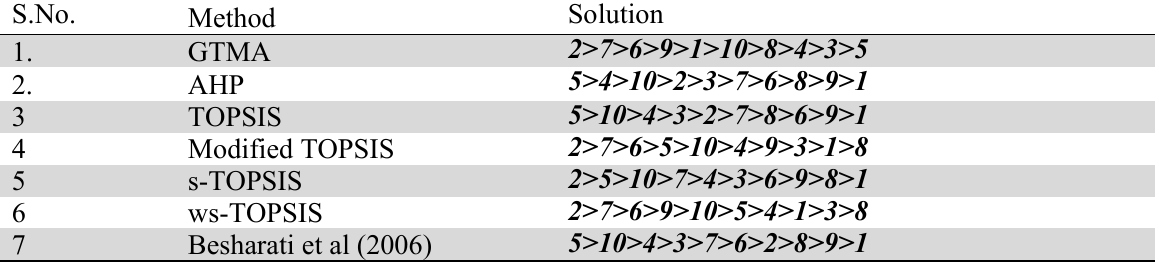
A comparison of the results obtained from different methods